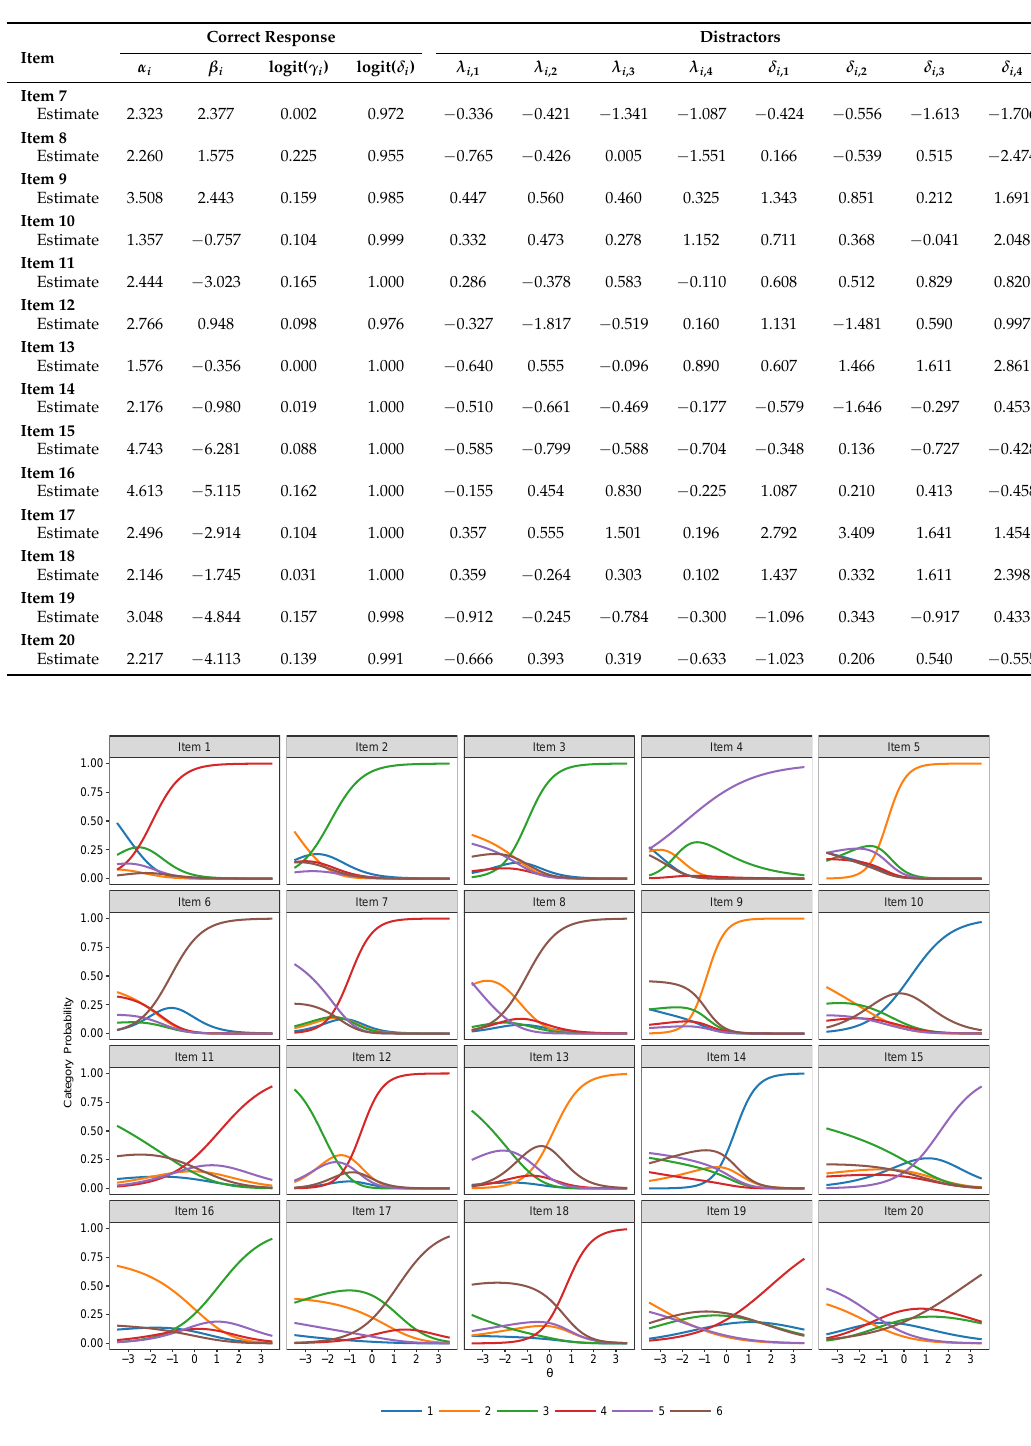
Figure 5. Item category curve plots of the 2-Parameter Nested Logit (2PNL)